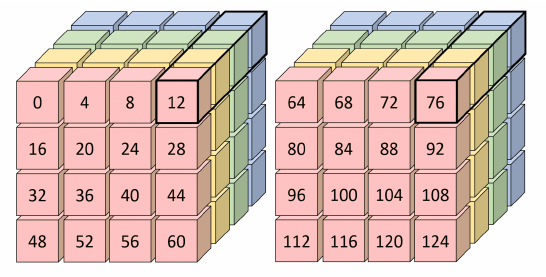
Figure 5: Cubic representation of the main state of GIFT-128 . The black cuboid is where an S-box is applied for both